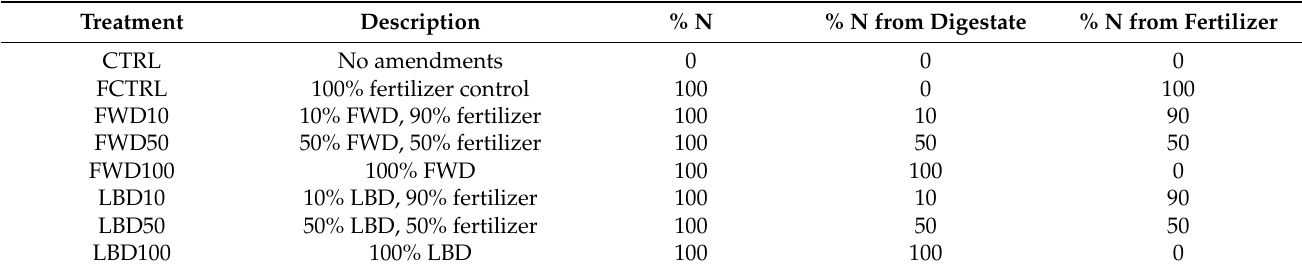
Table 2. Treatment specifications including proportion of N added per treatment, proportion coming from digestate addition and proportion from organic